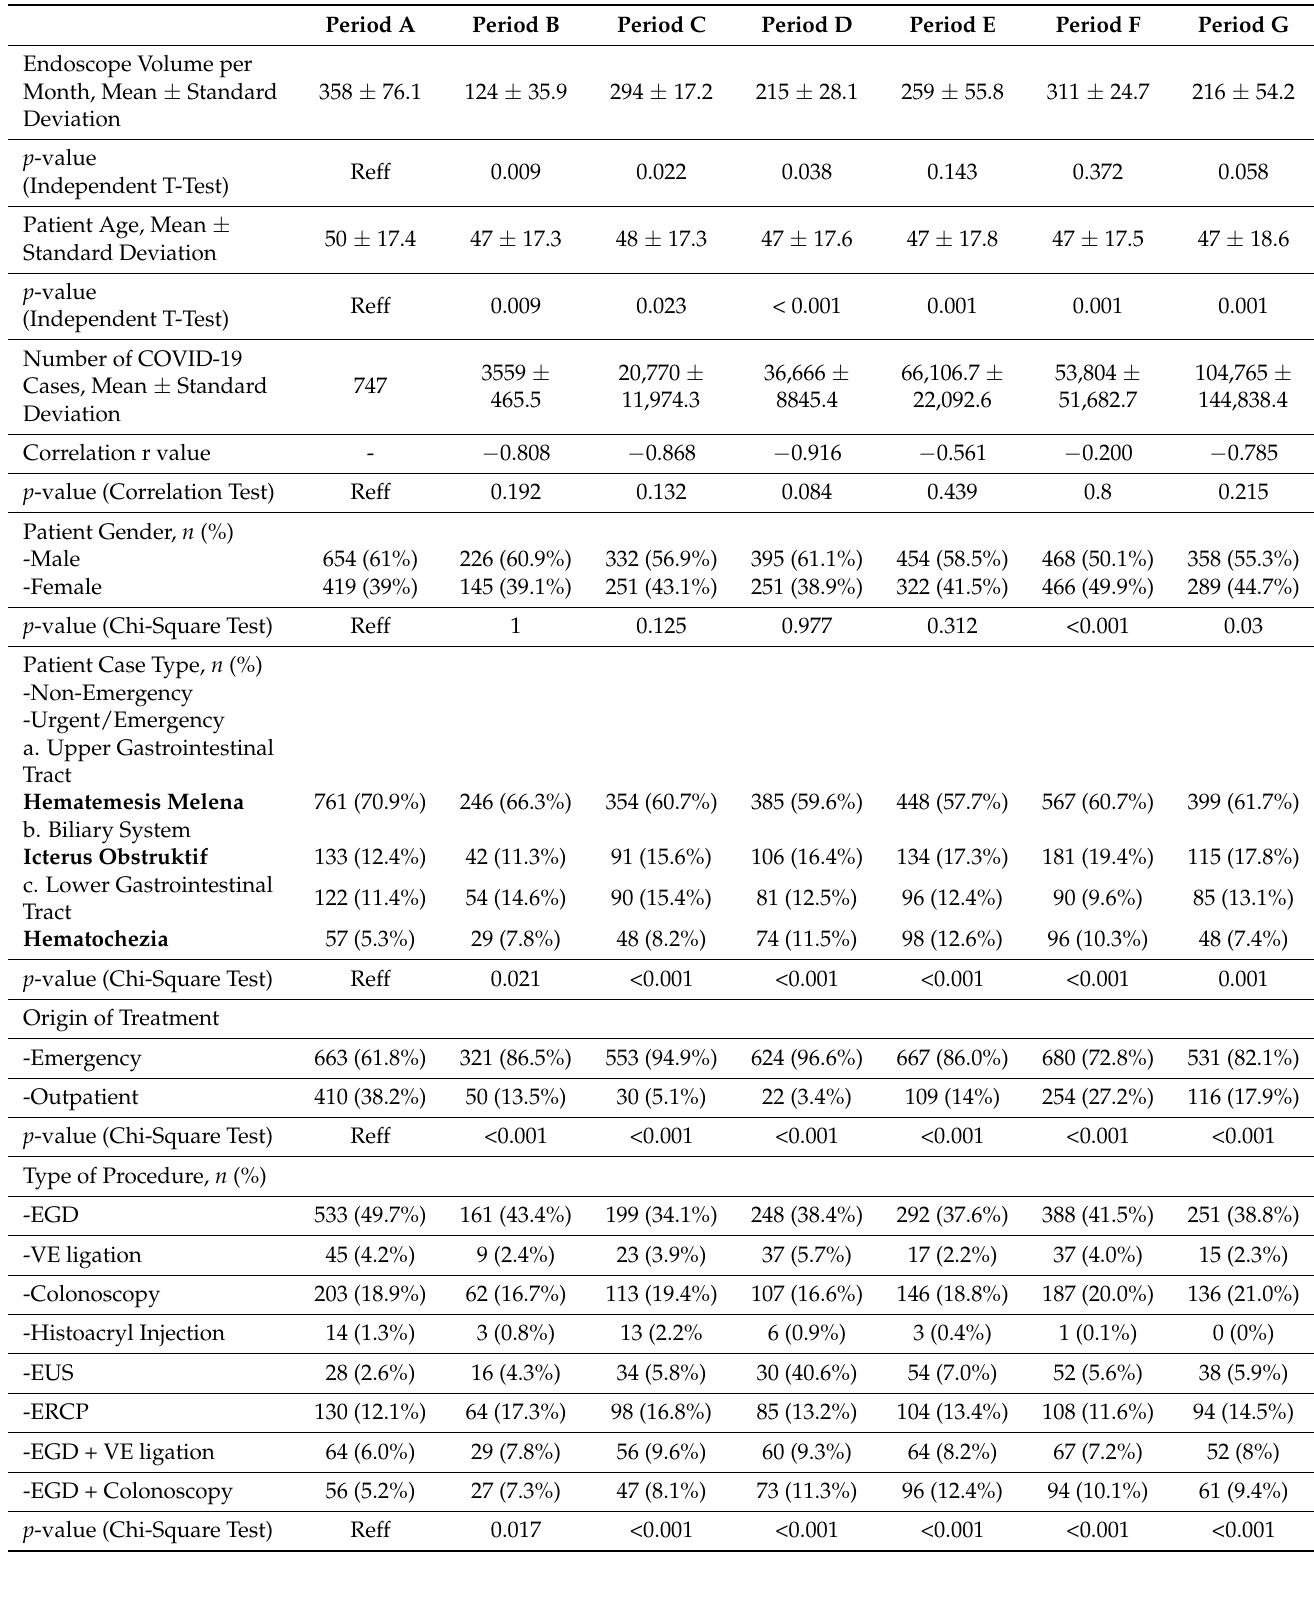
Table 5. Comparison of Endoscopy Volume, Patient Age, Number of COVID-19 Cases, Gender Proportion, Type of Patient Case, Origin of Care, and Type of Endoscopic Procedure before and During the COVID-19